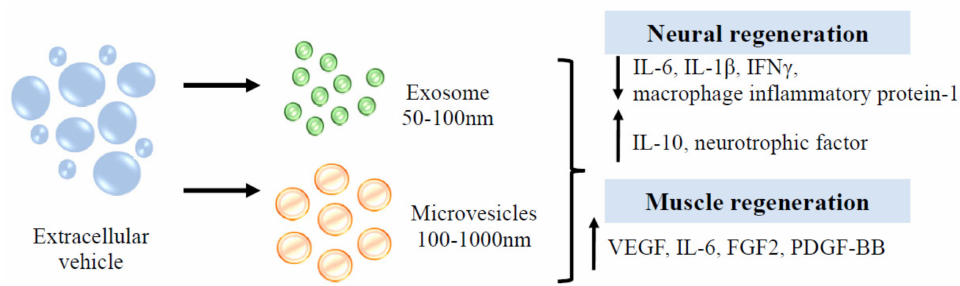
Figure 7. Function of EVs in neuron and muscle